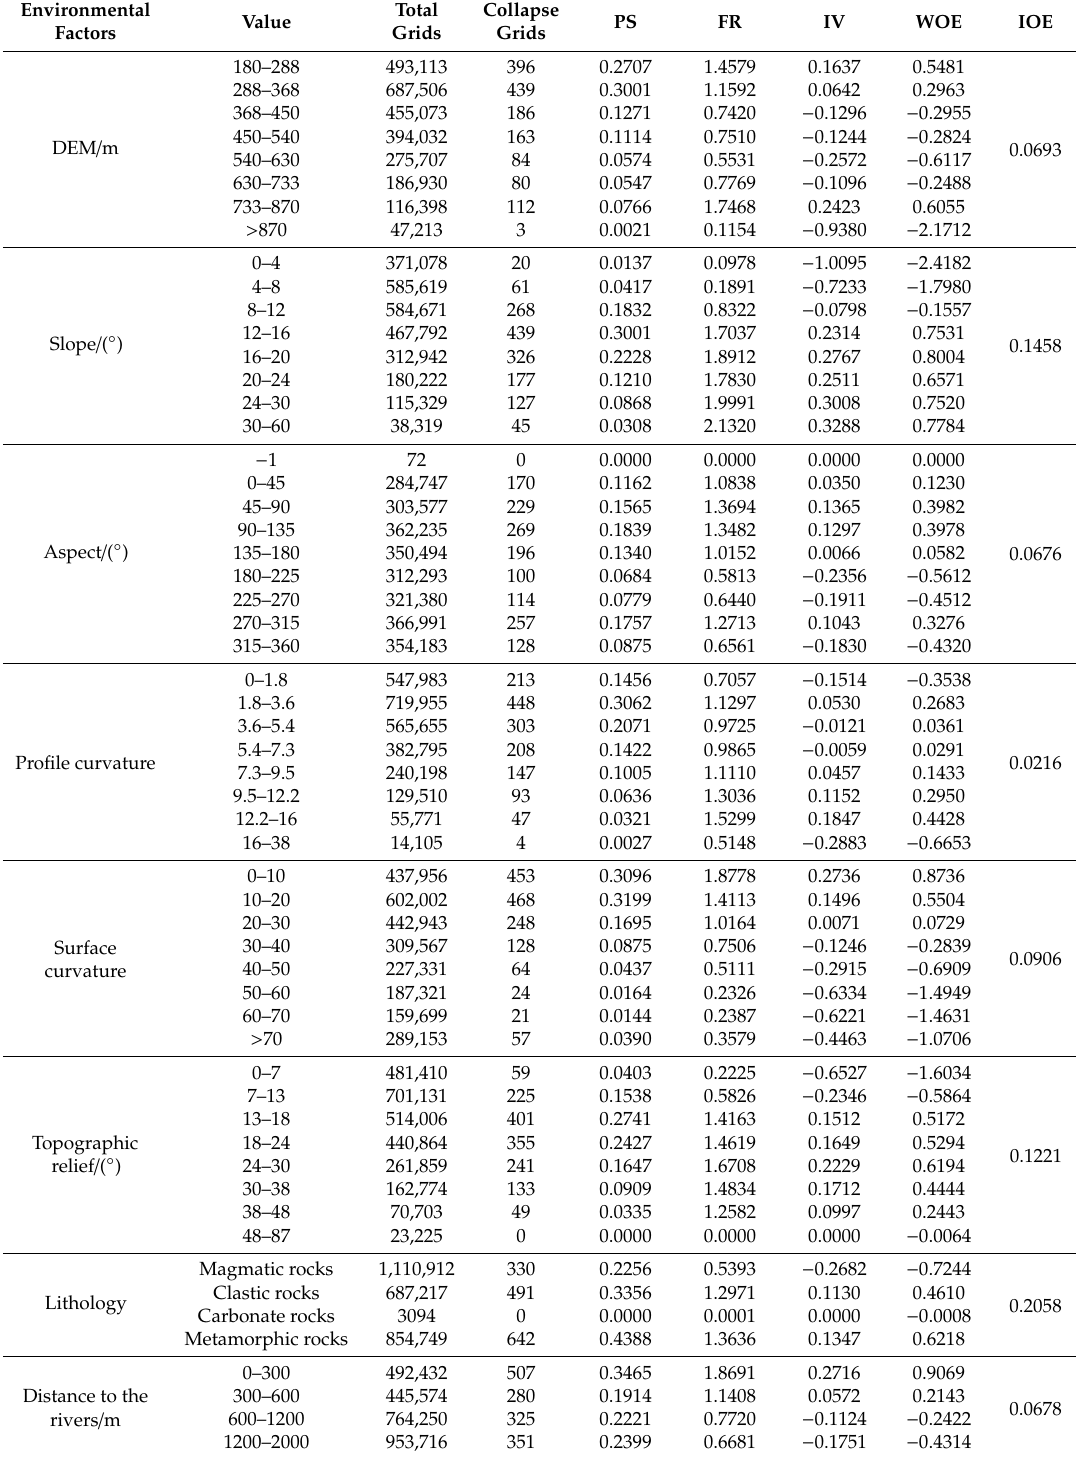
Table 2. Environment factors and calculation results of all connection